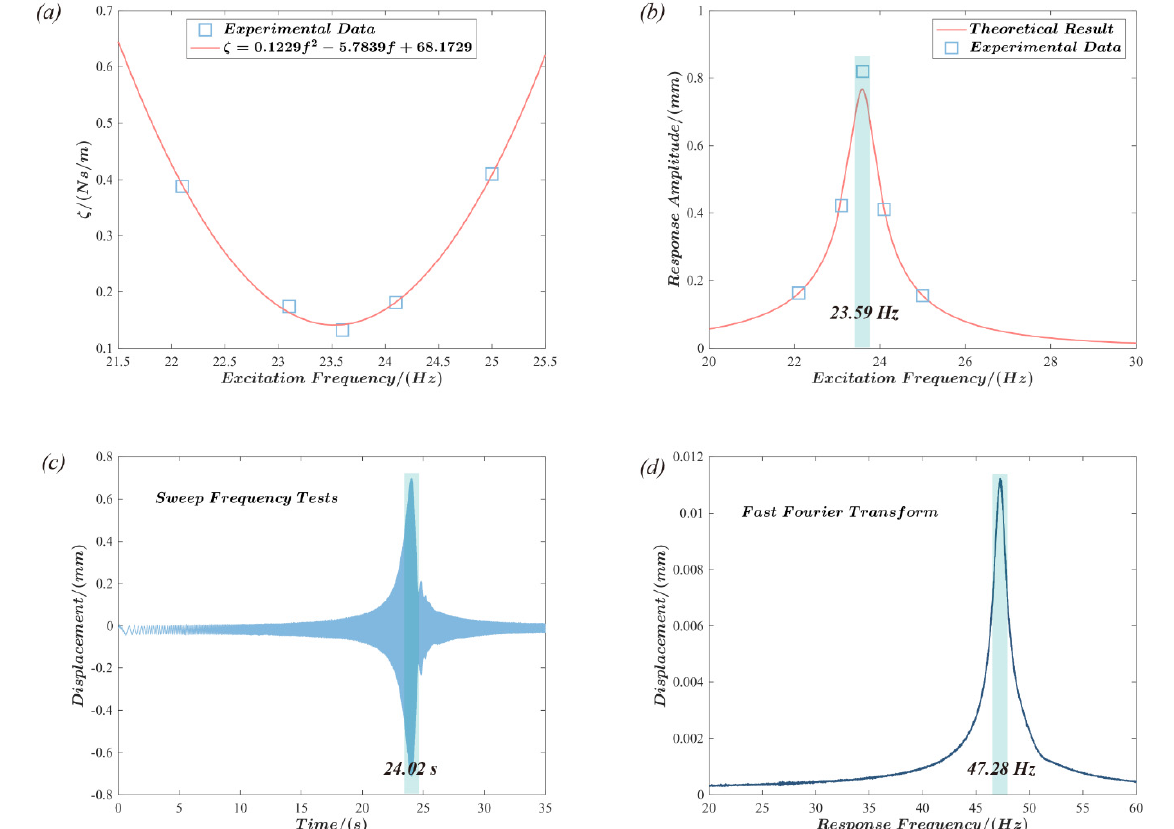
Figure 7. Natural vibration characteristics of the push-pull DEA. ( a ): the mathematical relationship between the linear damping coefficient ζ and the excitation frequency f ; ( b ): theoretical analysis and experimental measurements were used to demonstrate the amplitude of the displacement response of the actuators under different excitation frequencies; the results show that the actuator exhibits a response peak at an excitation frequency of 23.59 Hz; ( c ) and ( d ): the time domain curves of the actuators under swept frequency tests and the frequency domain obtained after fast Fourier transformation, respectively. The time domain curve exhibits a peak at 24.02 s , while the frequency domain curve exhibits a peak at 47.28 Hz, which are approximately in a multiple relationship.